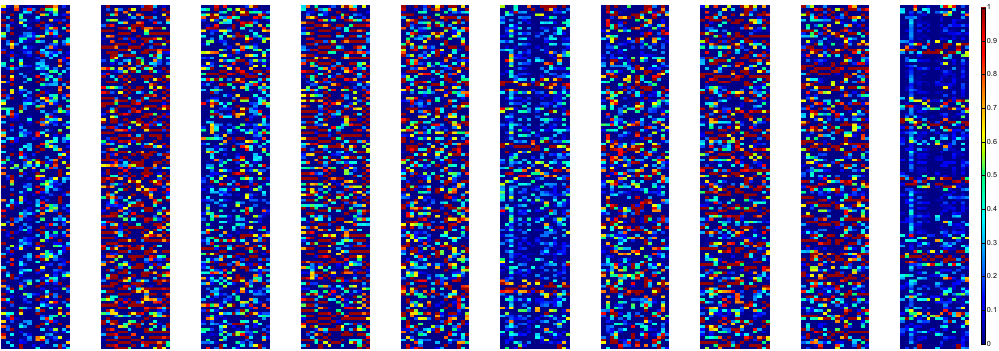
Figure 14. Visualization of the activations from the first convolutional layer with 10 kinds of fault signals as input. Red represents an activation of maximum, while blue means the neuron is not activated.